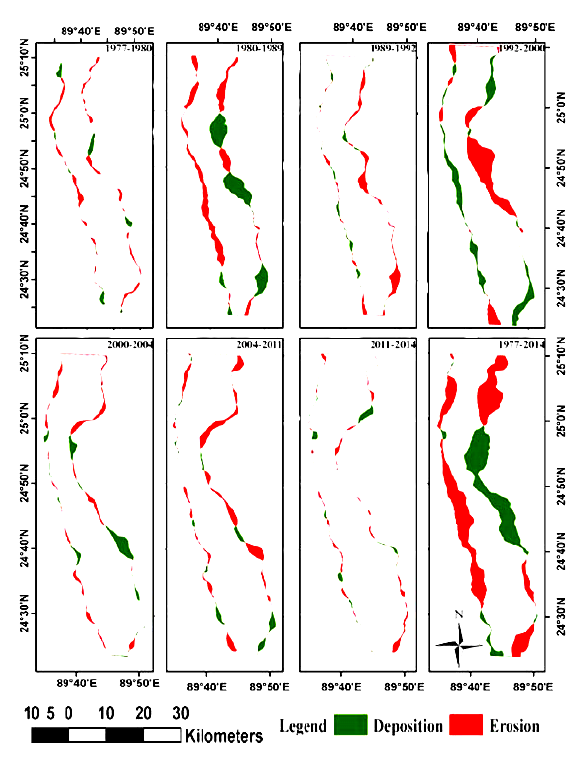
Figure 3. Erosion and Accretion